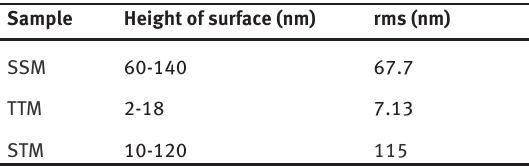
Table 3: The roughness parameter of SiO TiO /TiO /MTMS (TTM), and SiO 2 2 glasses by AFM measurements.